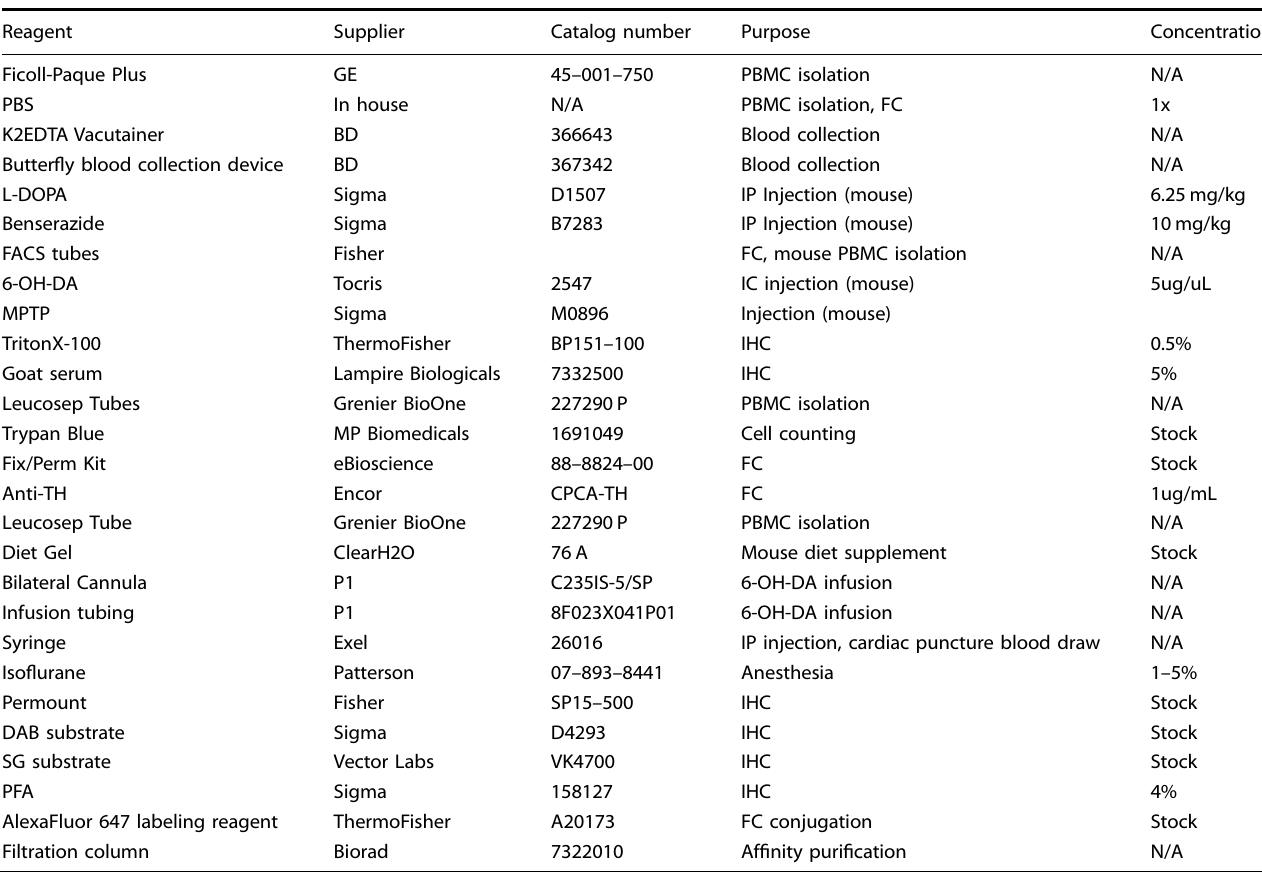
Table 2. Reagents and